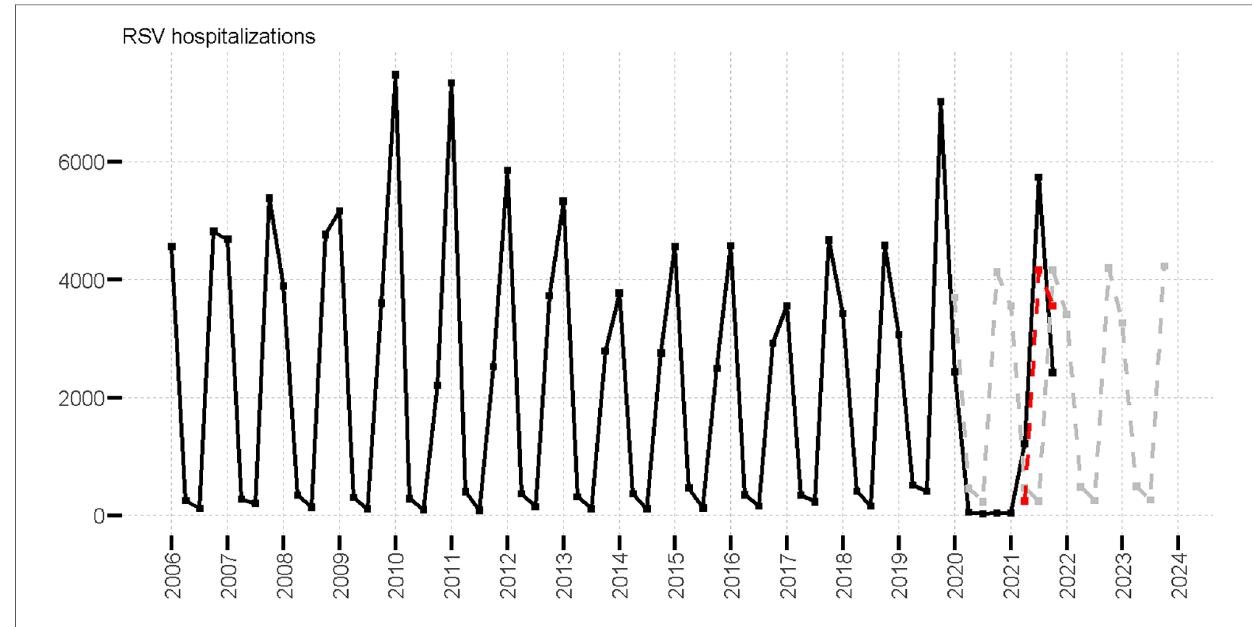
FIGURE 2 Observed RSV hospitalizations in patients aged four years and younger (black line), predicted RSV hospitalizations (gray dotted line), and predicted delayed RSV hospitalizations (red dotted line)